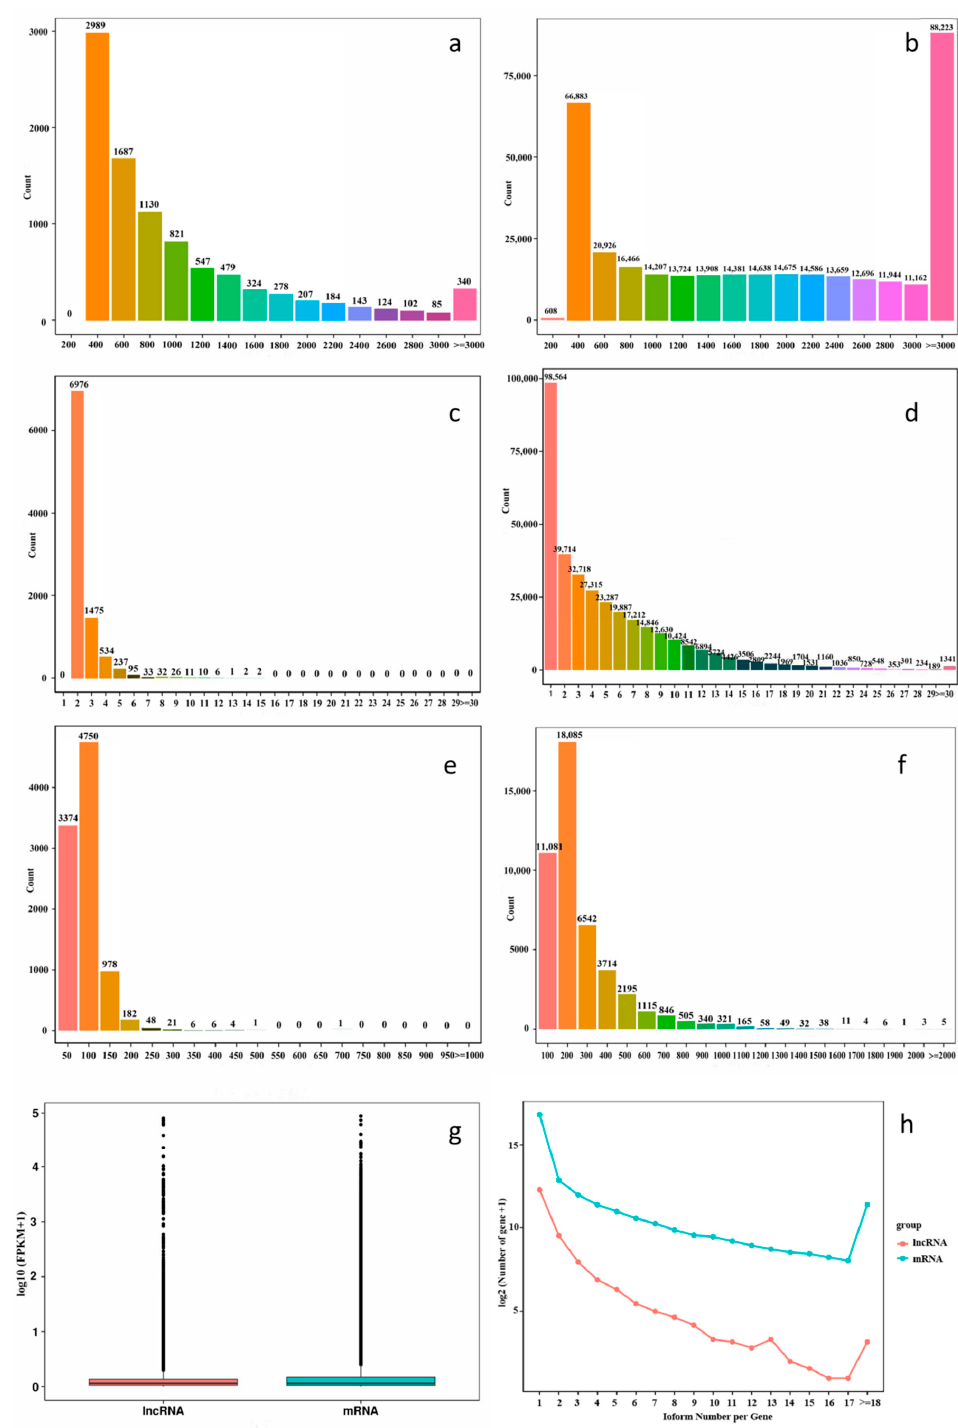
Figure 2. Comparison of the lncRNAs and mRNAs identified. ( a ) Length distribution of the lncRNAs. ( b ) Length distribution of the mRNAs. ( c ) Exon distribution of the lncRNAs. ( d ) Exon distribution of the mRNAs. ( e ) ORF lengths distribution of the lncRNAs. ( f ) ORF lengths distribution of the mRNAs. ( g ) Expression levels of the lncRNAs and mRNAs identified. ( h ) Isoforms of the lncRNAs and mRNAs